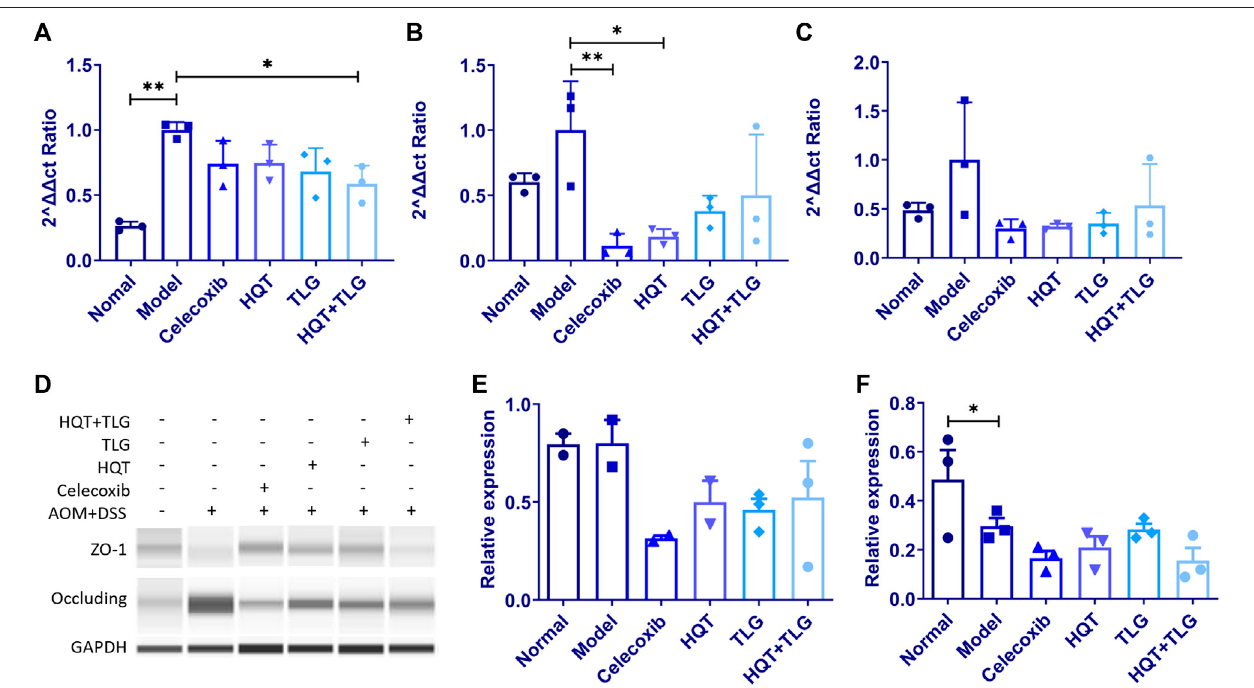
FIGURE 6 | The expression levels of intestinal claudin-1, occludin, and ZO-1 mRNA and protein in mice in each group. (A – C) Expression levels of claudin-1, occludin, and ZO-1 mRNA. (D – F) Expression levels of occludin and ZO-1 protein. Compared with the model control group, * p < 0.05.